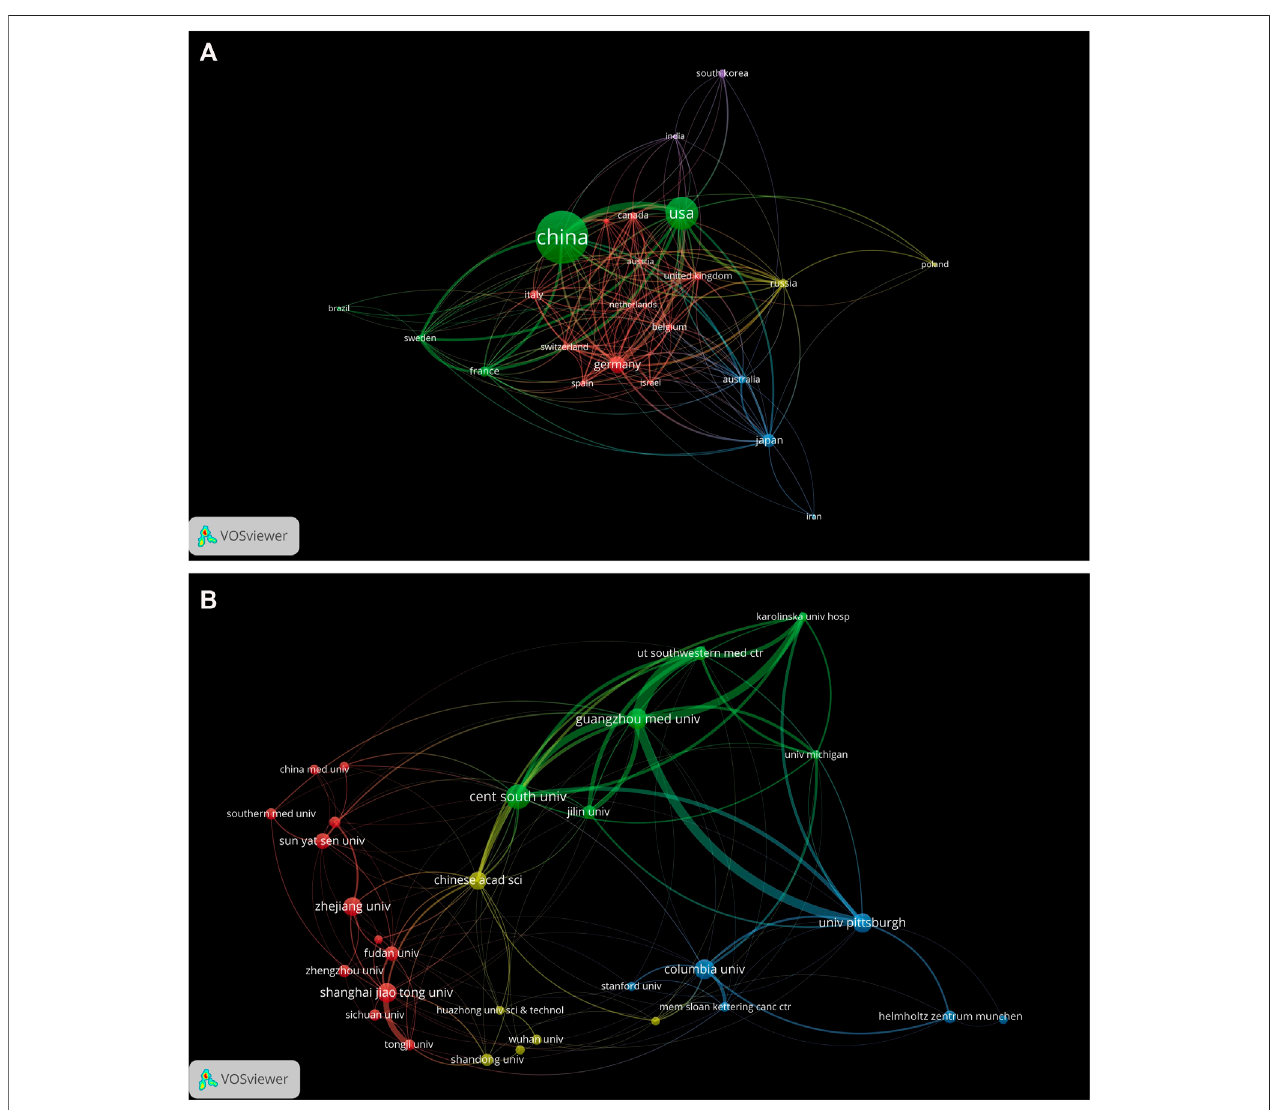
FIGURE 2 | Distribution of publications from different countries/regions and institutions. (A) Distribution of publications from different countries/regions (N = 23, Minimum number of publications of one country/region ≥ 10). Data from England, Scotland, and Wales were integrated into the United Kingdom; data from Taiwan and thePeople ’ sRepublicofChinawereintegratedintoChina.Thenodesrepresentedcountries/regionsandthesizeofthenoderepresentsthenumberofpublications.The lines between the nodes represent cooperation relationships and the thickness of the lines was correlated with the size of collaboration. The colors in the nodes represented the clusters. (B) Distribution of publications from different institutions (N = 30, Minimum number of publications of one institution ≥ 27). The nodes represented institutions and the size of the node represented the number of publications. The lines between the nodes represent cooperation relationships and the thickness of the lines was correlated with the size of collaboration. The colors in the nodes represented the clusters.